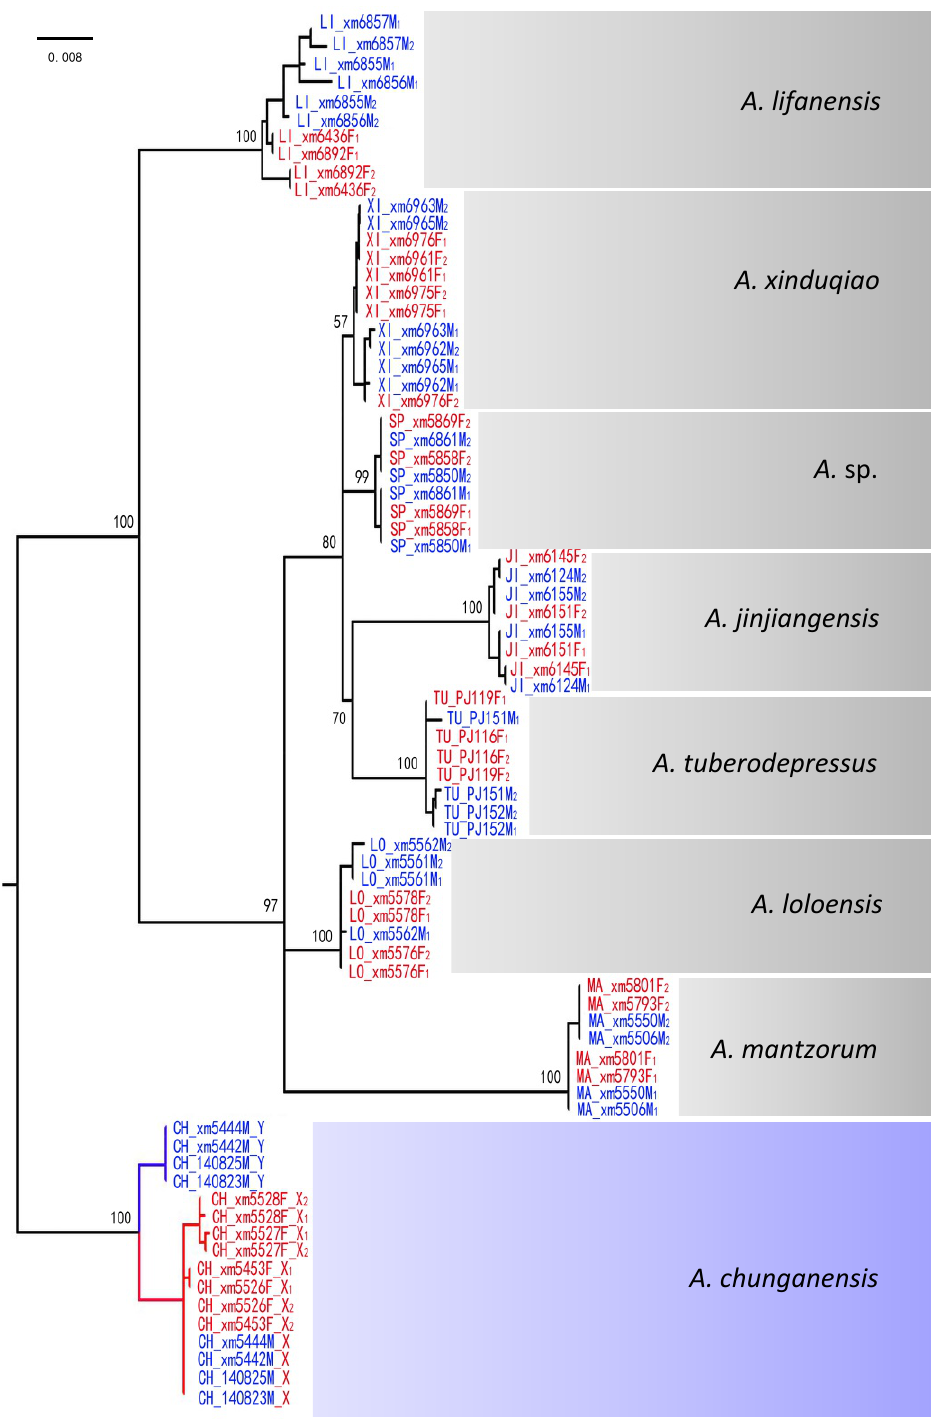
Figure 4. Gene genealogies of sex-linked loci outside ancestral SDR. Sequence labels of feature species (CH for A. chunganensis ; JI for A. jinjiangensis ; LI for A. lifanensis ; LO for A. loloensis ; MA for A. mantzorum ; SP for A. sp.; TU for A . tuberodepressus ; XI for A. xinduqio ), sex (M for male; F for female), ID number, and allele (X, Y). Sequences from male individuals are shown in blue, and those from females are shown in red. The markers are on sex chromosomes outside the ancestral sex-determining region (SDR) and thus sex-linked in A. chunganensis and not in the remaining seven species. All sequences group together by species genealogy, while X–Y recombination occurs in all the remaining species. Bootstrap values are shown for the main branches, when above